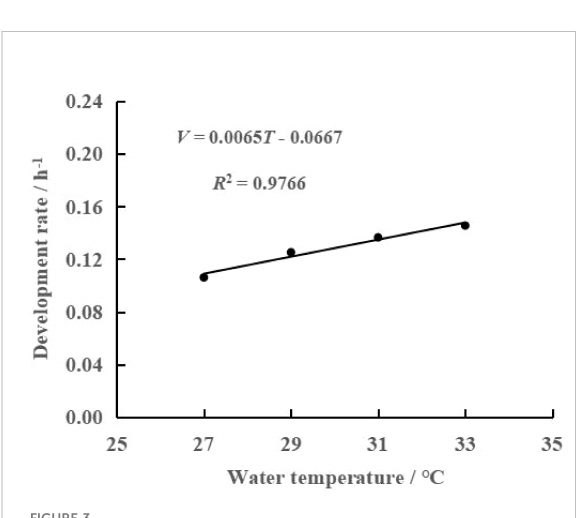
FIGURE 3 Relationship between rate ( V ) and water temperature ( T ) for embryonic development of swimming